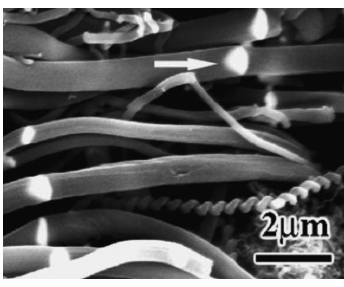
Figure 11. SEM image of bidirectionally grown straight carbon filaments at 953 K [45]. Reprinted with permission from [45], Copyright 2005 Elsevier.